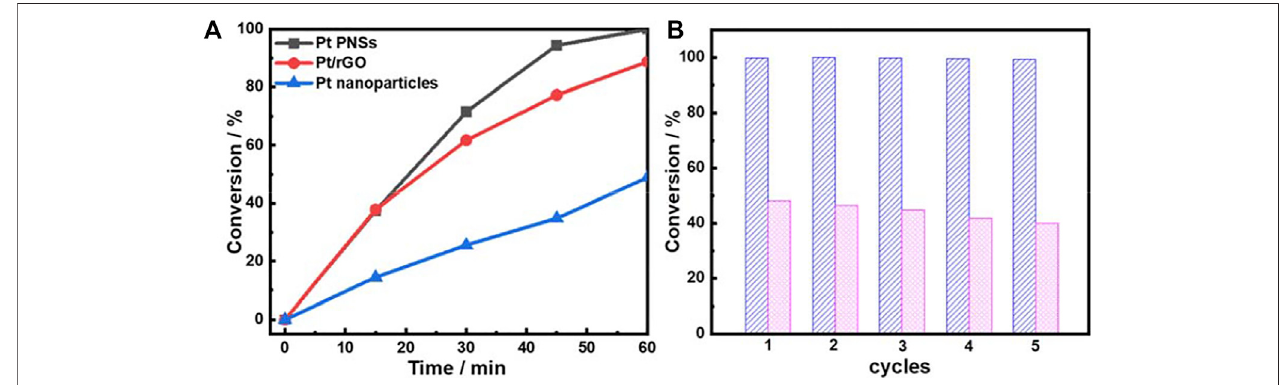
FIGURE4| Theplots ofconversion versus time forthehydrogenation of (A) p-chlorostyrene, (B) p-methylstyrene, (C) cyclohexene, and (D) nitrobenzene over the Pt PNSs catalyst under room temperature and normal pressure with a H 2 balloon as the H 2 supplier.